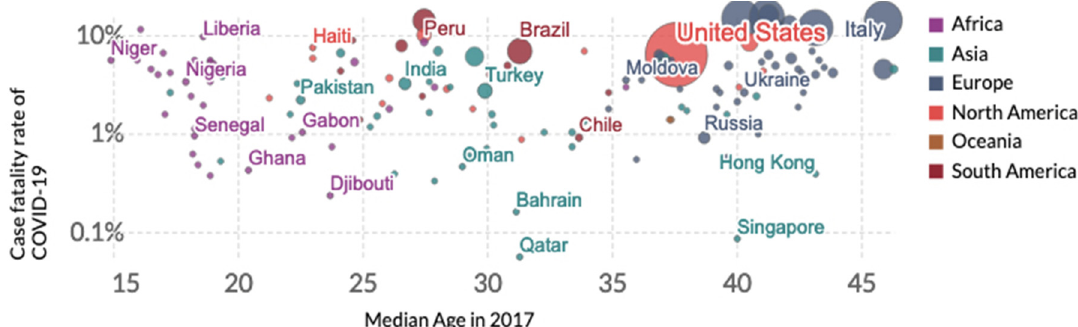
Figure 1. Dependence of the case fatality rate (from cumulative deaths on the 20 May 2020) vs. median age of several countries in 2017 (from [1]). The area of a country circle is proportional to the number of cumulated deaths due to COVID-19 on the 20 May 2020, e.g., for the USA: 99,643 (in red).